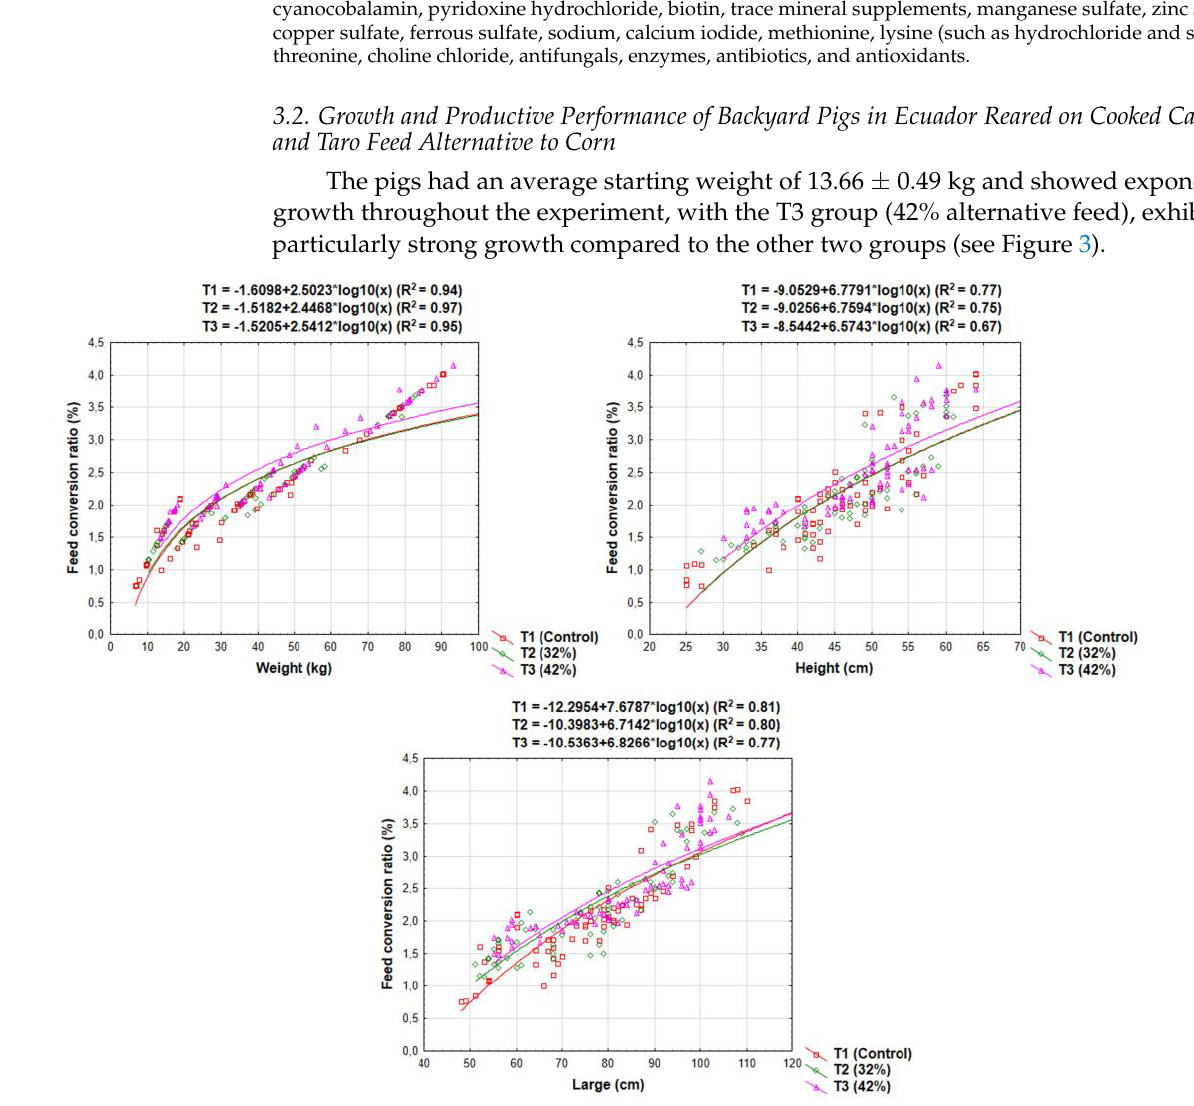
Figure 3. The relationship between body traits and feed conversion ratio in each treatment. T1: conventional feed with no corn replacement; T2: corn replacement with 32% of cassava + taro; and T3: corn replacement with 42% of cassava + taro.